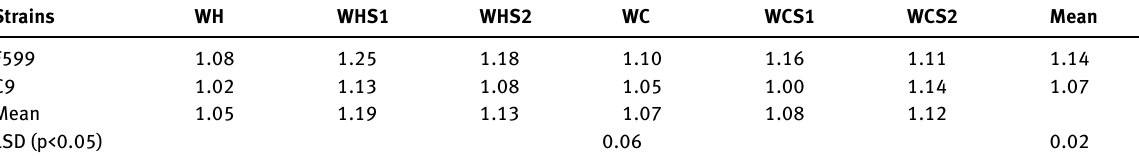
Table 4: Ratios of the diameter of pileus to the length of stipe (DP/LS ratio) of A. bisporus on various composts MeanWCS2WCS1WCWHS2WHS1WHStrains